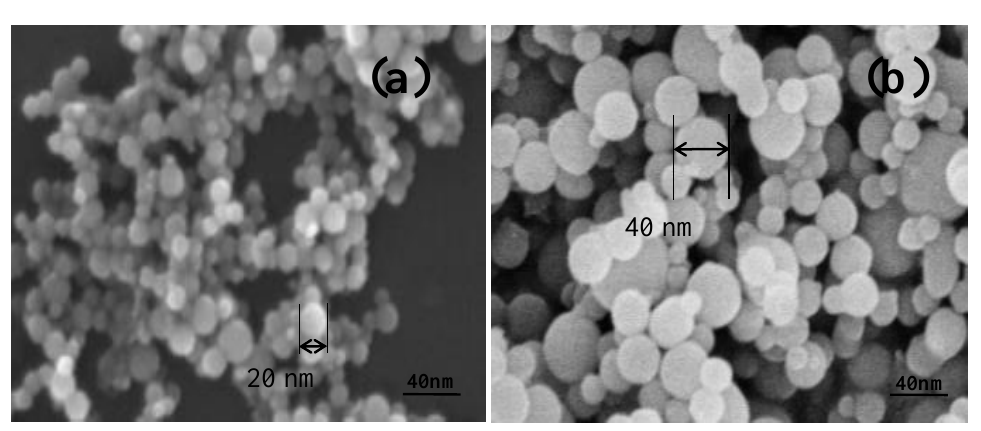
Figure 2. SEM image of cross-section of composite material of ABS and Al: ( a ) 20 nm and ( b ) 40 nm nanoparticles from 0 to 12